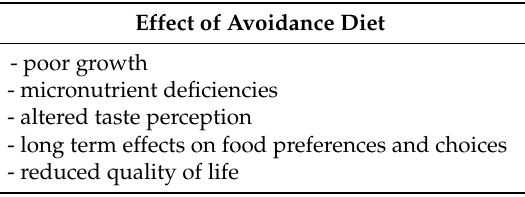
Table 2. Effect of avoidance diet on